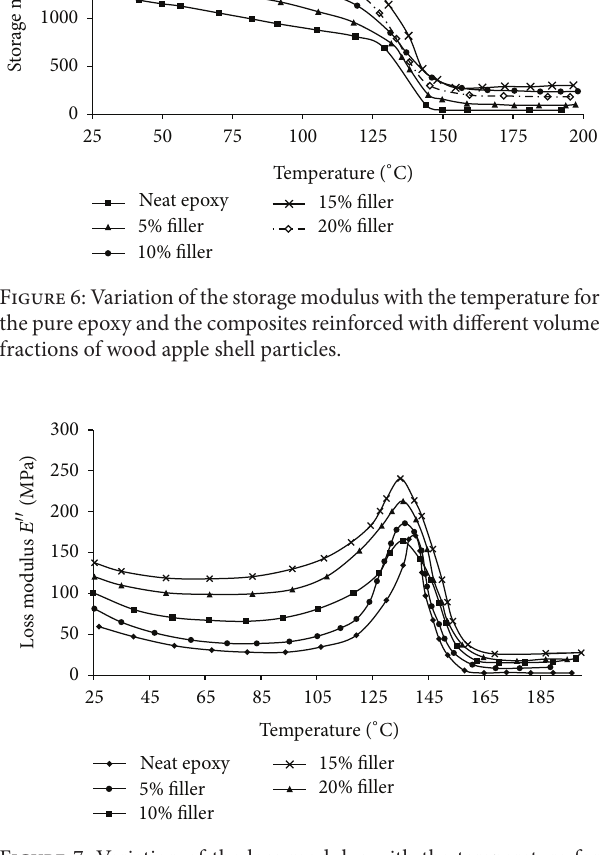
Figure 7: Variation of the loss modulus with the temperature for the pure epoxy and the composites reinforced with different volume fractions of wood apple shell particles.